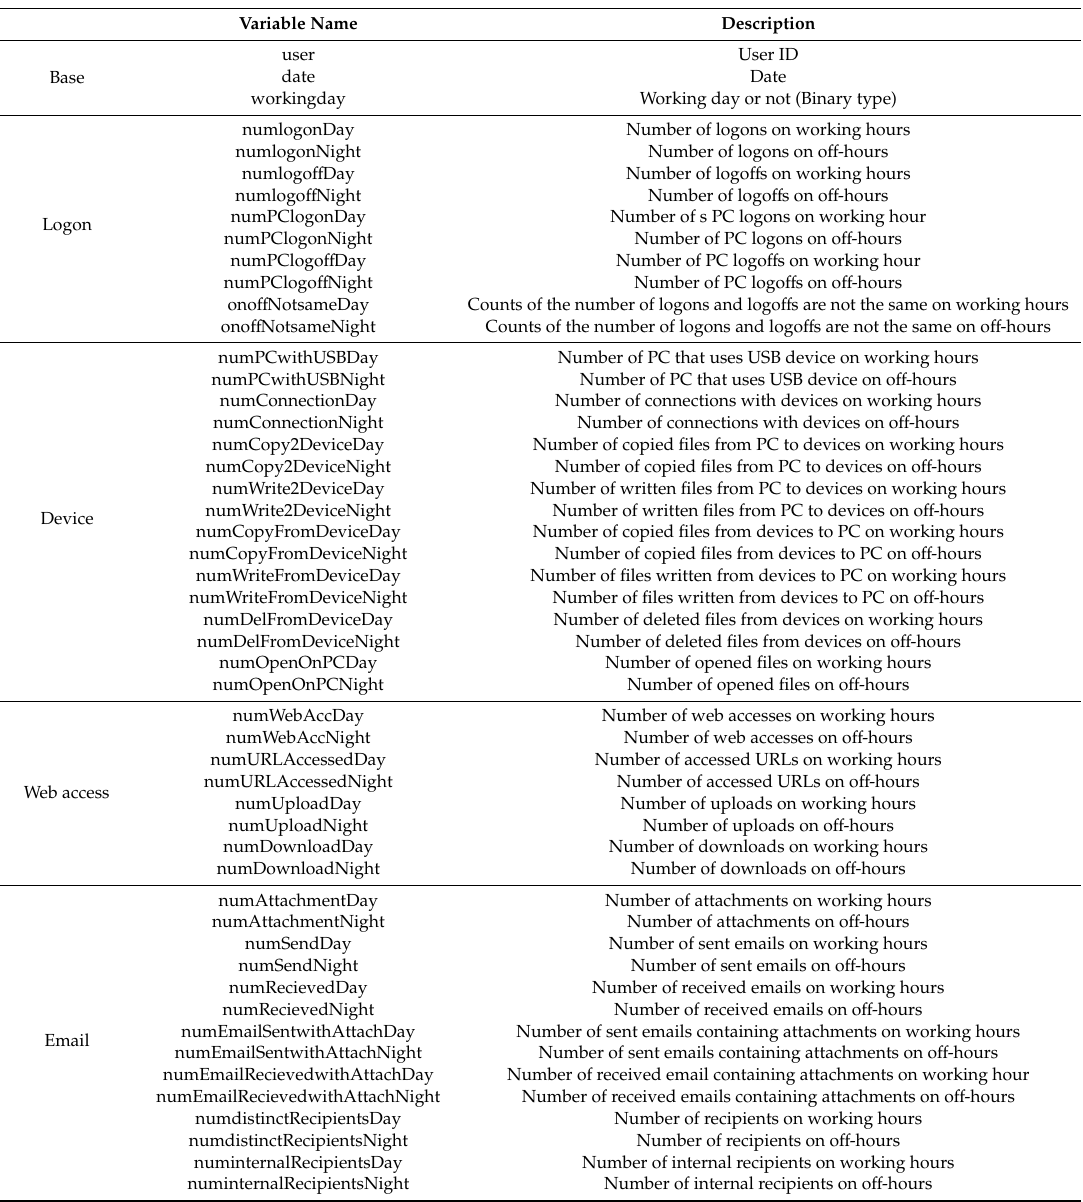
Table A2. List of variables extracted from integrated daily